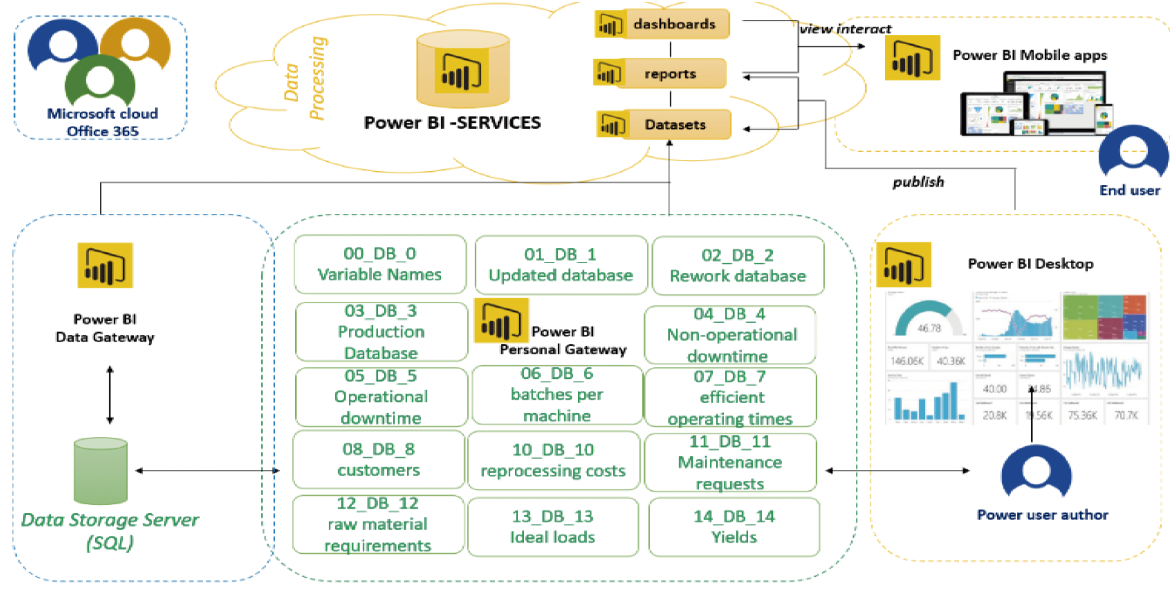
Figure 3. SQL Databases -architecture and